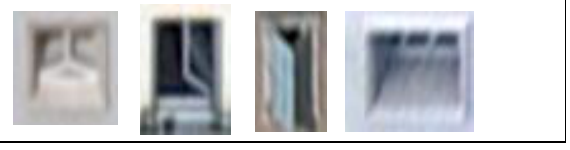
Figure 9. Low resolution, open windows, closed shutters and important distortion due to perspective are obstacle to window characterization